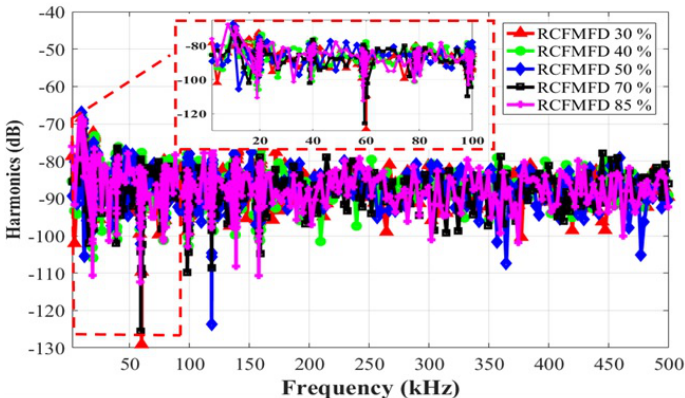
Figure 17. Comparison of the switching current harmonics results for various randomness levels of RCFMFD for an interleaved buck converter.